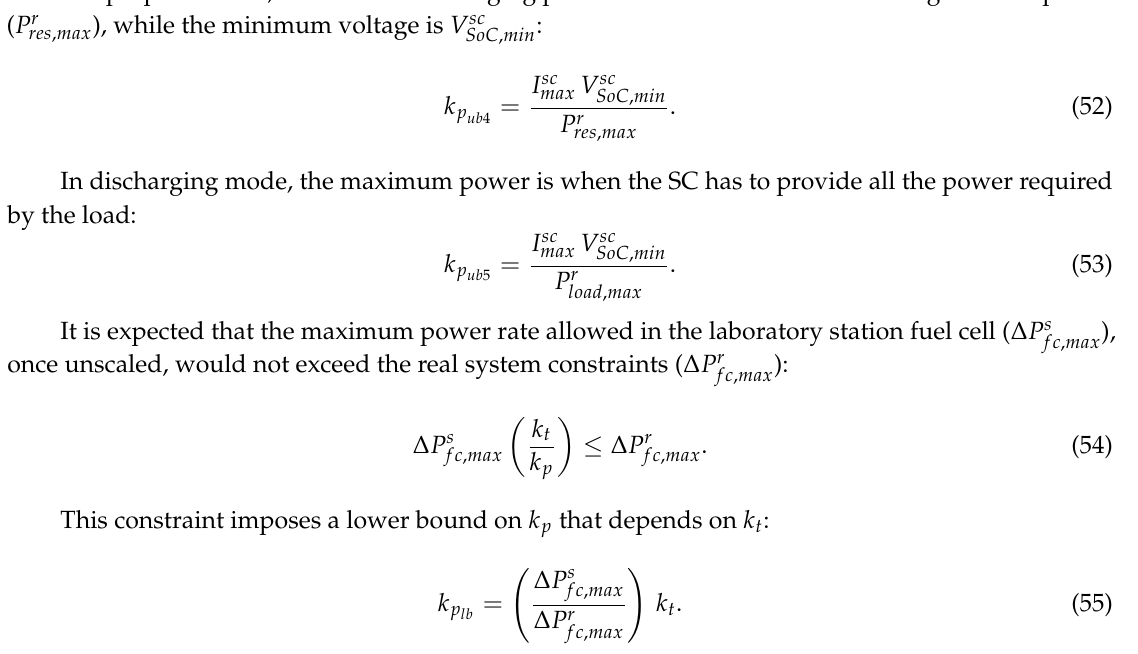
) and most restrictive upper bound ( k p lb